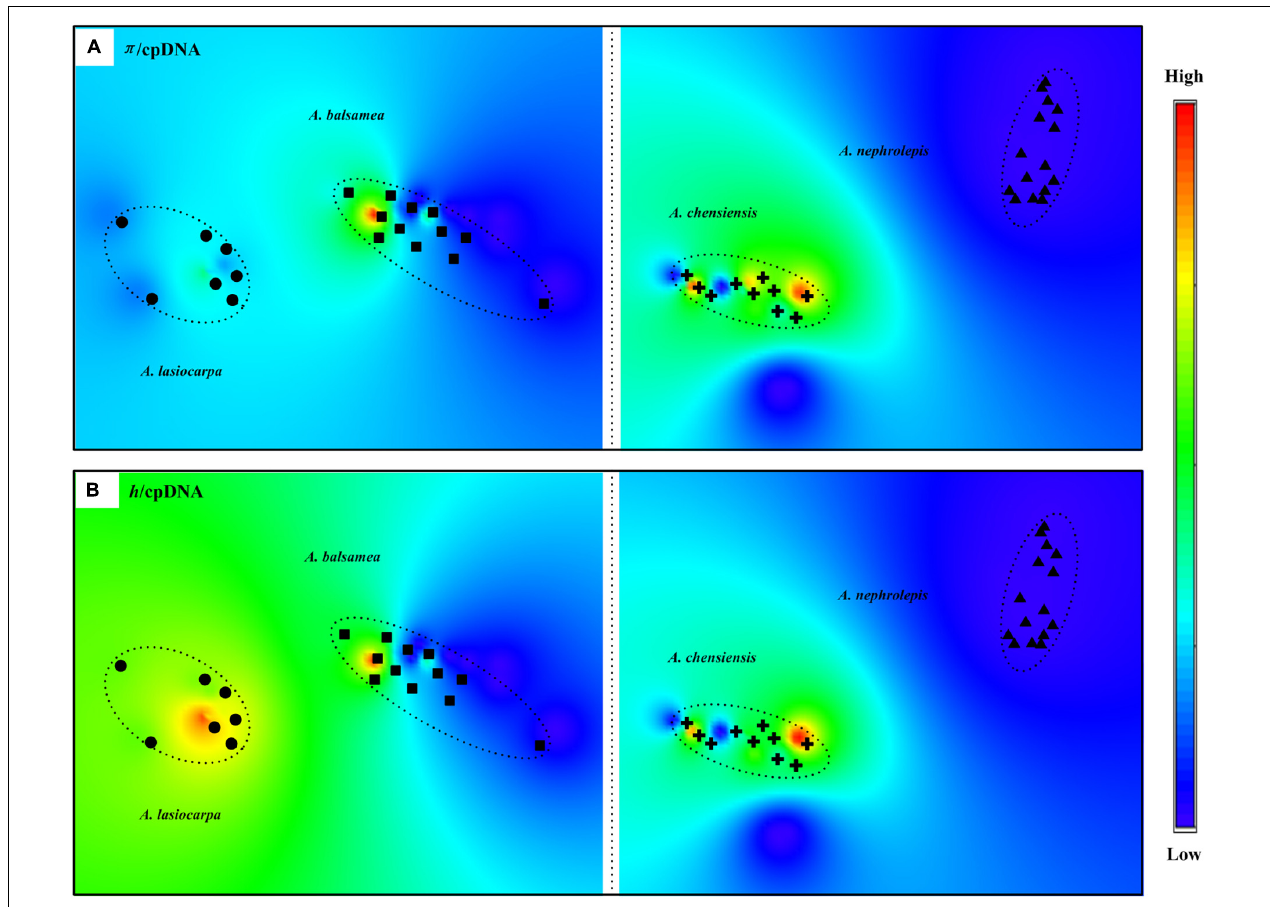
FIGURE 4 | Genetic diversity of cpDNA haplotype across the range of the four fir species. (A) Distribution of cpDNA nucleotide diversity ( π ). (B) Distribution of cpDNA nucleotide diversity ( h ). X axis: longitude. Y axis: latitude.